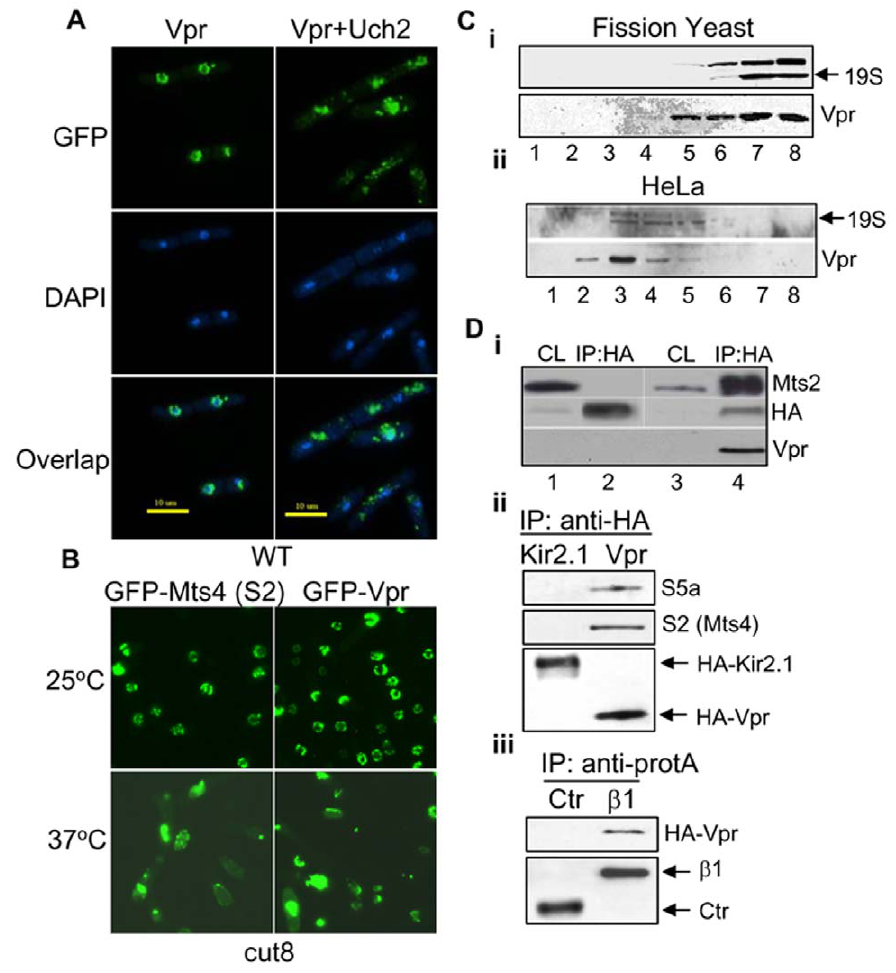
Figure 1. Vpr associates with proteasome in fission yeast and mammalian cells. A . Vpr is displaced from the nuclear membrane by overproduction of Uch2. Fission yeast cells carrying or not carrying Uch2 were stained with DAPI 17 hrs after vpr gene induction. Green color, GFP; Blue color, nuclear DNA. B . Vpr is displaced from the nuclear membrane in the cut8 mutant. Mts4, a fission yeast homologue of mammalian S2, is a 19S proteasome-associated protein. Cut8 displays normal phenotype at the permissive 25 u C, but shows mutant phenotype at non-permissive 37 u C. C . Co-migration of Vpr with proteasome in fission yeast cells ( i ) and HeLa cells ( ii ) analyzed by glycerol gradient. Extracts from fission yeast cells expressing vpr were fractionated by centrifugation on a 10–40% glycerol gradient. Equal amounts of proteins from each fraction of the gradient were separated on 12% SDS-PAGE and probed with antibodies against Vpr and 19S (Mts4) subunits of the proteasome [34]. Lanes 1–8 indicates different fractions collected from the top (low molecular weight) to bottom of the gradient (high molecular weight). Note that not all fractions are shown here. D.i . Co-immunoprecipitation shows interaction of Vpr with Mts2 in yeast cells. IP was carried out with anti-HA as described previously [59]. A HA-tag alone plasmid control was used in this experiment. The recovered proteins were fractionated on SDS-PAGE and immunoblotted with anti-HA, anti- Vpr and anti-Mts2 antibodies. CL, cell lysates; IP:HA, immunoprecipitation with a HA-tagged control plasmid; IP:HA-Vpr, immunoprecipitation with a HA-Vpr carrying plasmid. ii . HeLa cells were transfected with HA-Vpr or HA-Kir2.1 (control). Kir2.1 is an irrelevant protein to Vpr and used here as a control. IP was carried out with anti-HA, recovered proteins were fractionated on SDS-PAGE and immunoblotted with anti-S2 (a mammalian homologue of fission yeast Mts4) and anti-S5a antibodies. iii . HeLa cells were co-transfected with pSG5-ZZ- b 1, which codes for a proteasomal b 1subunit [38], or control pSG5-ZZ plasmid (Ctr) together with HA-Vpr. The protein A-tagged b 1 or control protein were pulled down by anti-protein A antibody, then blotted with anti-HA